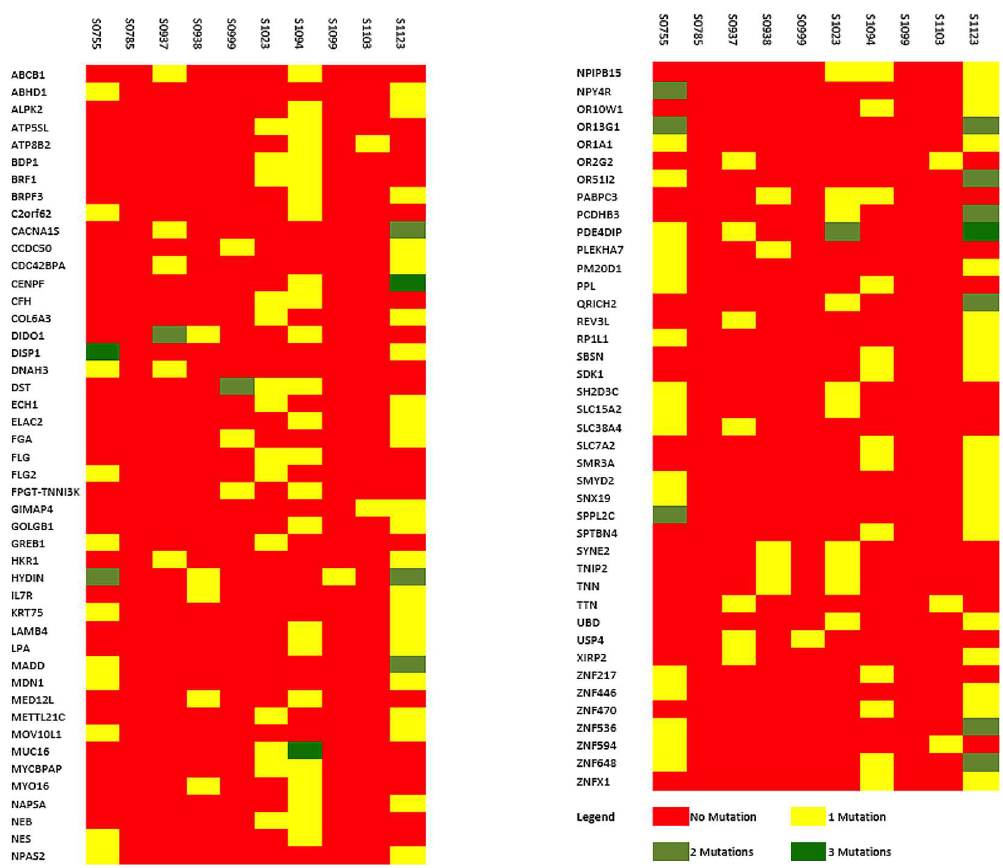
Fig 2. Heat map of frequently mutated genes. A panel of 87 geneswas found to be mutated in at least 2 tumour samples. Some of the geneshad 3 mutations in the same sample.